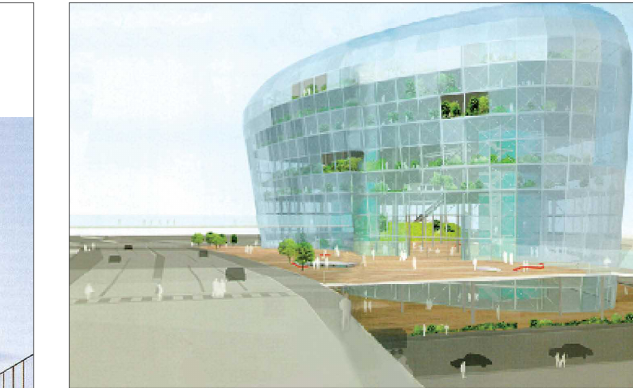
Fig 9. Morioka Library in Japan (2001)